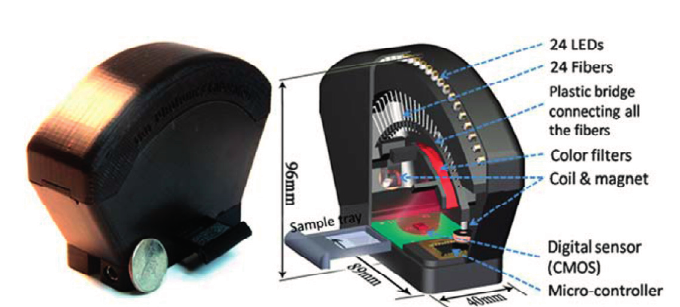
Figure 12. An image ( left ) and a schematic image ( right ) of the field-portable lensless tomographic microscope. It weight ~110 g which employed 24 LEDs as light source and the LEDs were mounted along arc structure for providing images at different angle